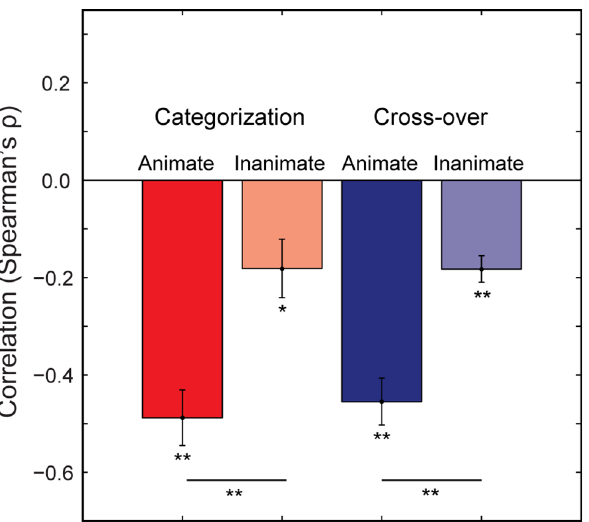
Fig 7. Time-averaged (0 – 600 ms) correlations between representational distance and RTs for both animate and inanimate object exemplars. Mean time-averaged categorization (red) and cross-over (blue) correlations (Spearman ’ s ρ ) between representational distances and RTs. Asterisks indicate significant comparisons (Wilcoxon Signed Rank Test; * = p < .01; ** = p < .001). Error bars indicate +/- 1 SEM across